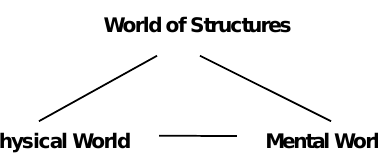
Figure 1. A graphical representation of the Existential Triad of the World.